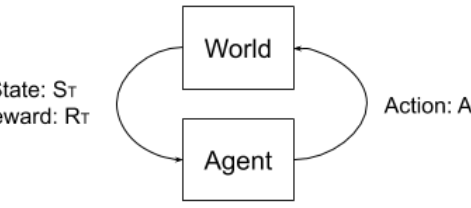
Figure 3. The Markov chain illustration. The agent acts in the world and receives back a state and a reward value. This return is used to update the learned values of the